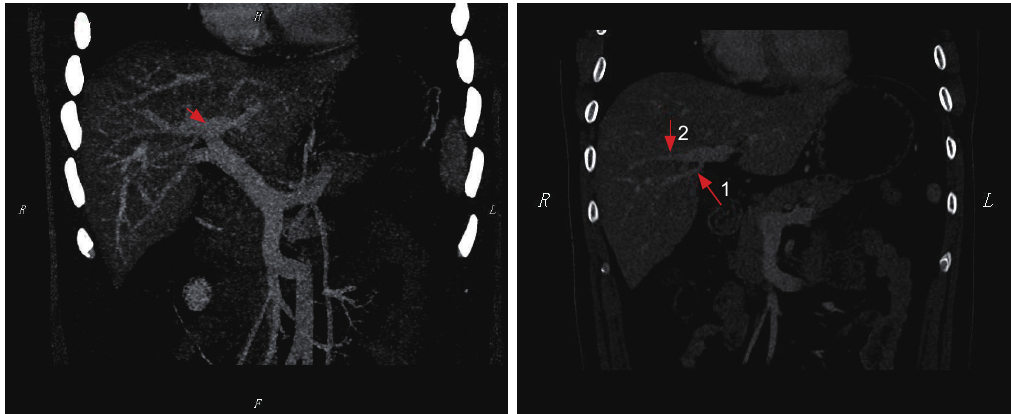
Figure 2 (A) The right anterior branch kept going to the right superior for 2cm then made a sudden anterior turn to form the vertical portion. The red arrow is the vertical portion (left). (B) The right one coursed for 1cm followed by three branches to right anterior, right superior and right posteroinferior. The red arrow 1 is right posteroinferior branch, the red arrow 2 is right superior